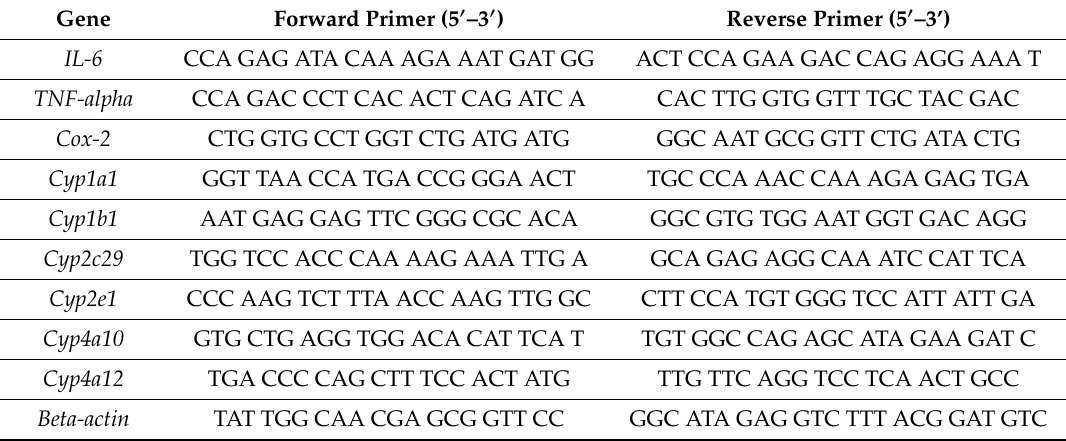
Table 2. Primers used in this